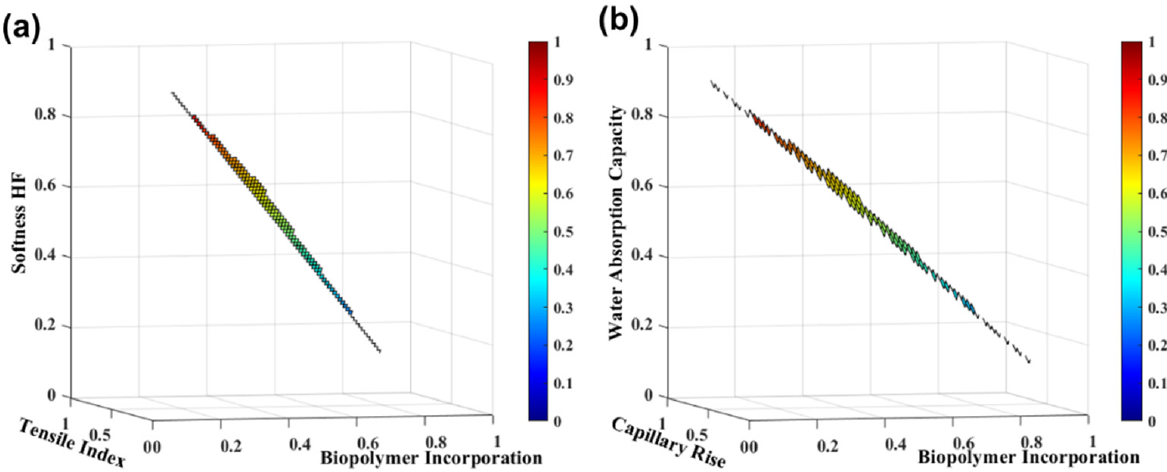
Figure 8. TSA-softness HF and tensile index properties ( a ) and water absorption capacity and capillary rise ( b ) with biopolymer incorporation in a eucalyptus slush pulp. The variables were normalized.